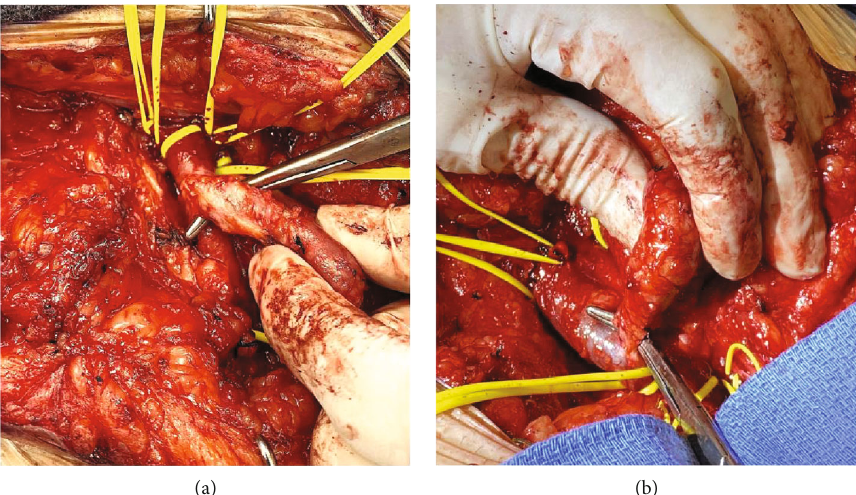
Figure 3: Views of the arterial and venous connections to the structure. (a) Arterial connection to AV fi stula and pseudoaneurysm. (b) Venous connection to AV fi stula and pseudoaneurysm.